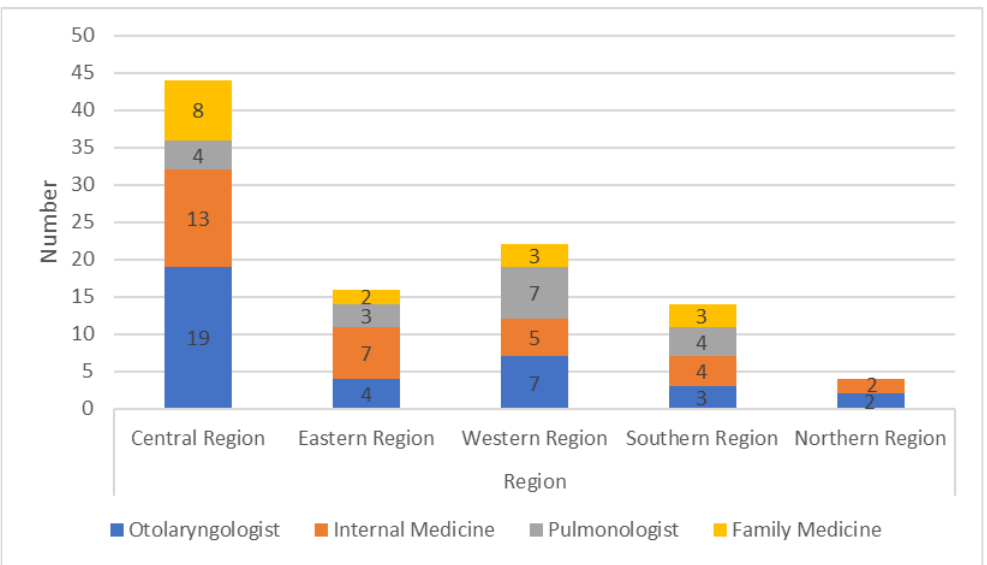
Figure 2. Distribution of specialties across the different regions. The rate of reported referral for OAs was meager, as most physicians (62%) have never referred for OAs, while only 4% have referred at least one patient every month. When evaluating factors influencing patients’ referral frequency for OAs, it was observed that awareness of the topic, reported knowledge of OAs, and knowing a dentist qualified in OSA were significant positive predictors of the frequency of referral of patients. The regression model also showed that perceptions of side effects or knowledge of the mechanism of action of OAs had no impact on the frequency of referral (Table Table 2. Participant’s responses to the knowledge and attitude questions ( n = 100).